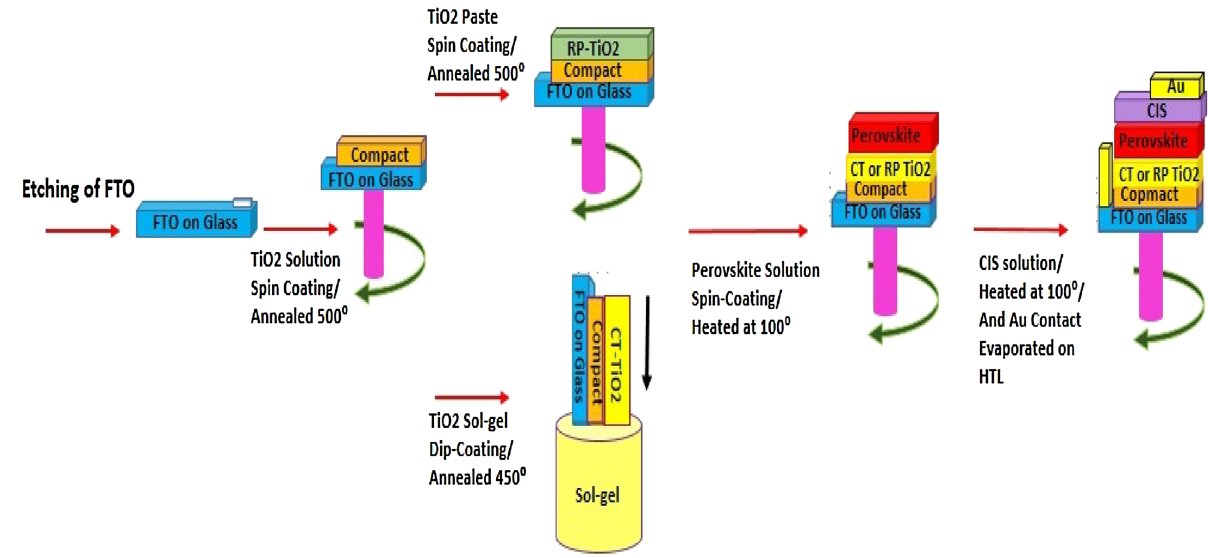
Figure 10. Schematic illustration of the PSC fabrication based on CT and RP